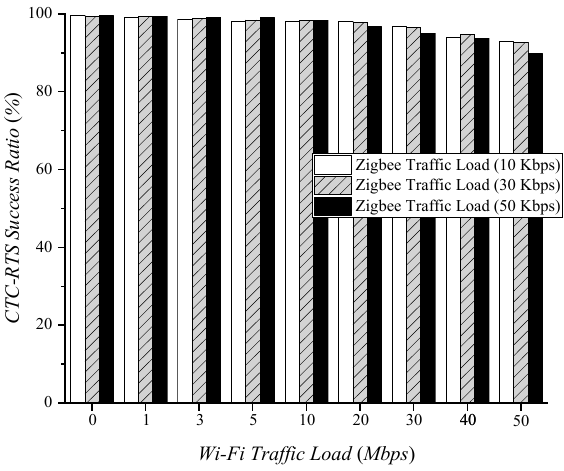
Figure 6. CTC-RTS success ratio according to Wi − Fi traffic load.